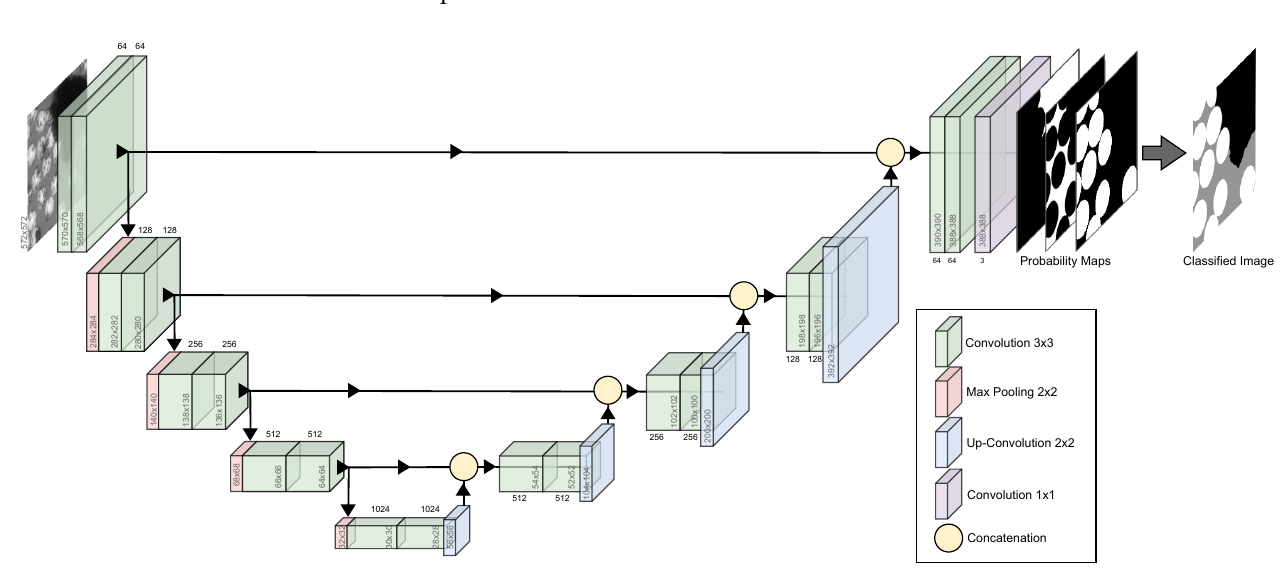
Figure 4. A schematic image of the U-Net architecture.